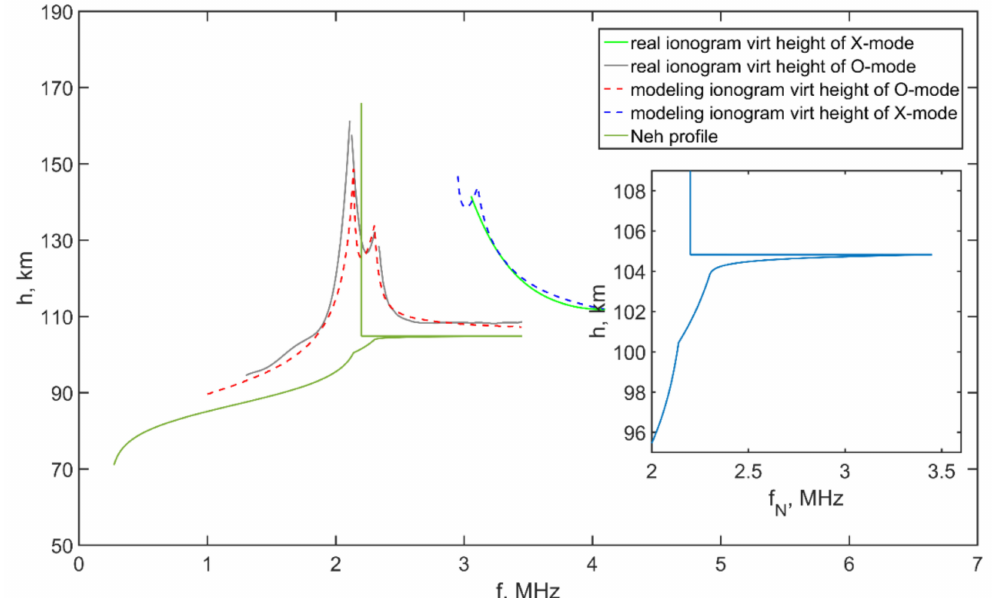
Figure 5. Digitized real ionogram (dependence of the virtual height h on the frequency f ) for the O-mode (gray curve) and X-mode (green curve). Here, the dashed line shows the dependences h ( f ) calculated as a result of modeling for the O-mode (red curve) and X-mode (blue curve). The electron density profile N ( h ) used for calculating the h ( f ) dependence is shown in yellow. The inset on the right shows an enlarged fragment of the lower part of the N ( h ) profile of the E and E s